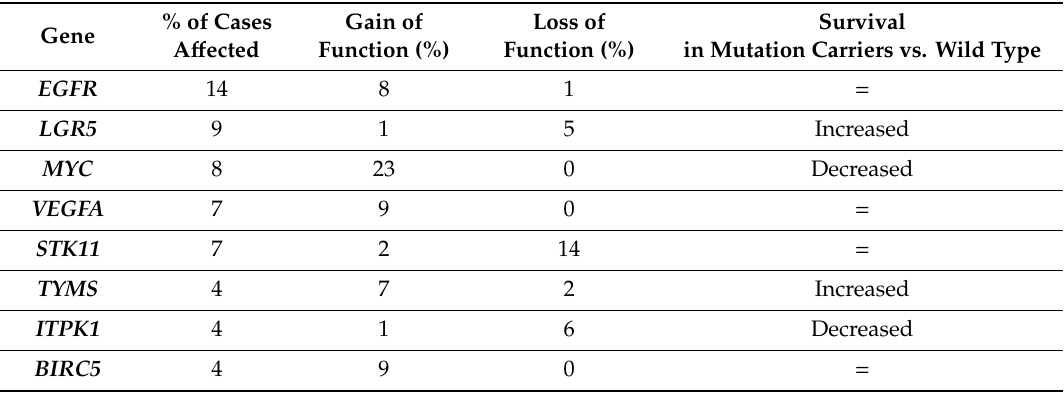
Table 4. TCGA database results of genes mutated in colon–rectal cancer encoding for mRNAs associated with neoadjuvant rectal CRT